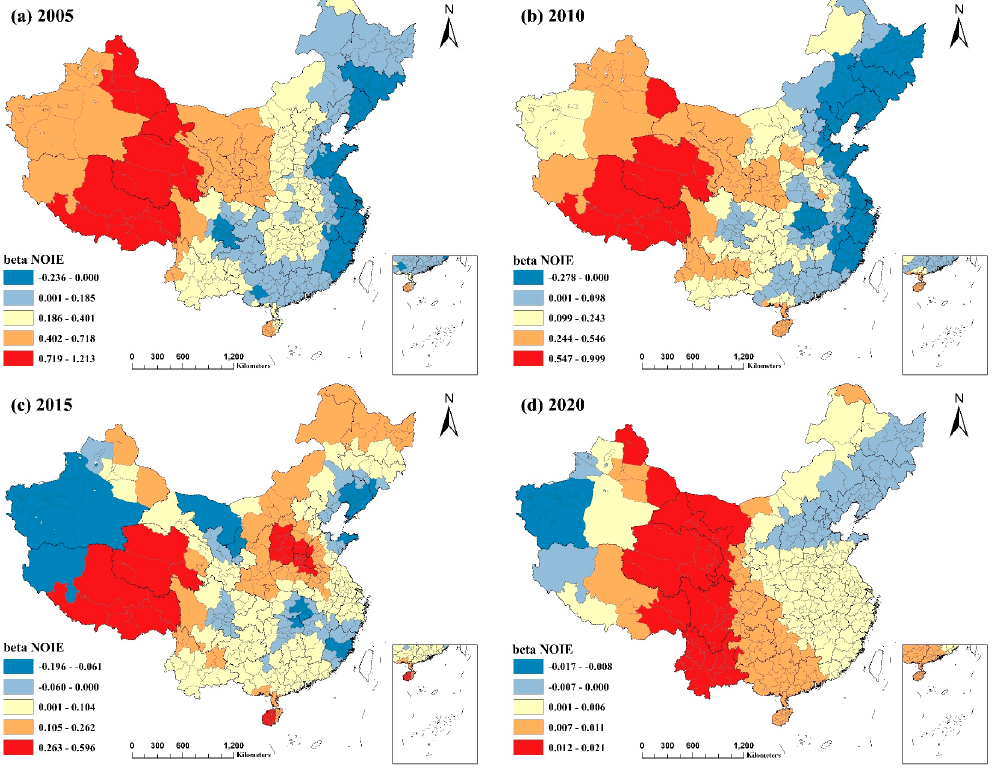
Figure 8. Spatial and temporal distribution of regression coefficients of the number of industrial enterprises above the scale in the MGWR model, 2005 − 2020: ( a ) spatial and temporal distribution of regression coefficients for the number of industrial enterprises above the scale in 2005; ( b ) spatial and temporal distribution of regression coefficients for the number of industrial enterprises above the scale in 2010; ( c ) spatial and temporal distribution of regression coefficients for the number of industrial enterprises above the scale in 2015; ( d ) spatial and temporal distribution of regression coefficients for the number of industrial enterprises above the scale in 2020.